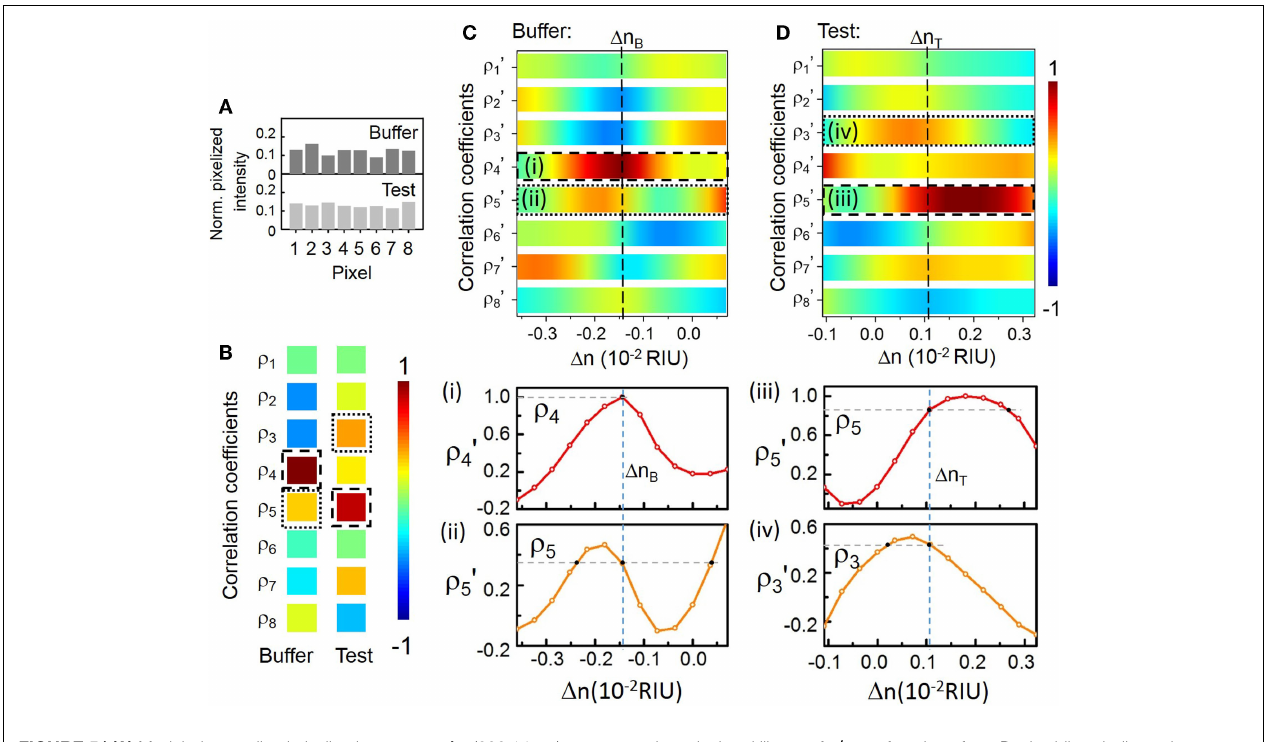
the calculated library of ρ ′ j as a function of ∆ n . Dashed-lines indicate the mapping of ∆ n B , ∆ n T for buffer solution and test solution, respectively. Insets (i)–(iv): Mapping of ρ p and ρ s with the library to extract ∆ n B and ∆ n T